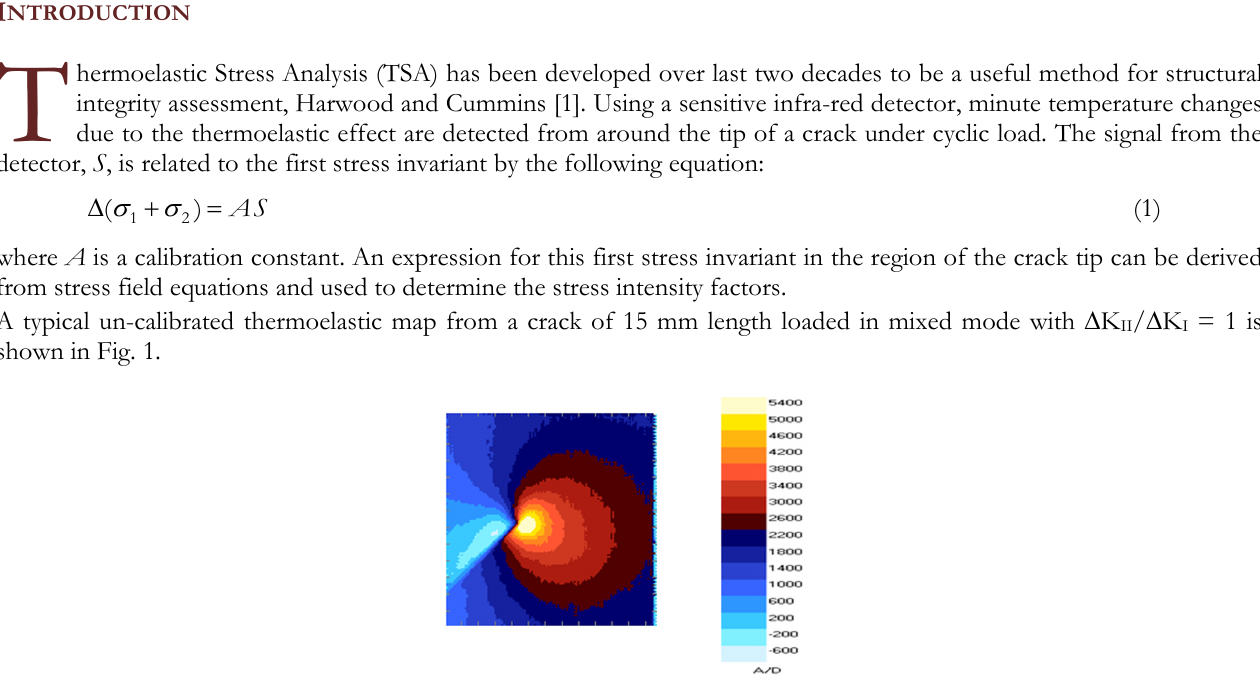
Figure 1: Thermoelastic data around a 15 mm crack loaded in mixed mode with applied mixed mode ratio  K II /  K I =